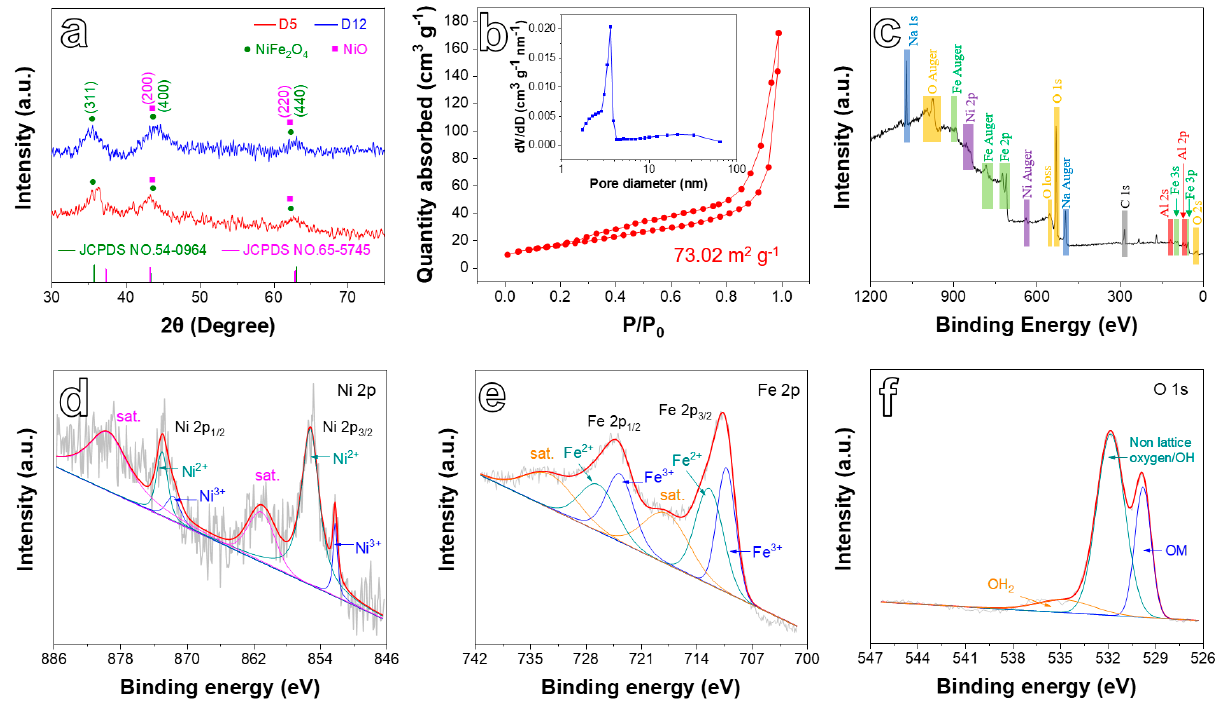
Figure 3. ( a ) XRD pattern of obtained samples. ( b ) N 2 adsorption–desorption isotherm of the D5 sample and corresponding pore size distribution (inset). XPS spectra of the D5 sample: ( c ) survey spectrum, ( d ) Ni 2p, ( e ) Fe 2p, and ( f ) O 1s.